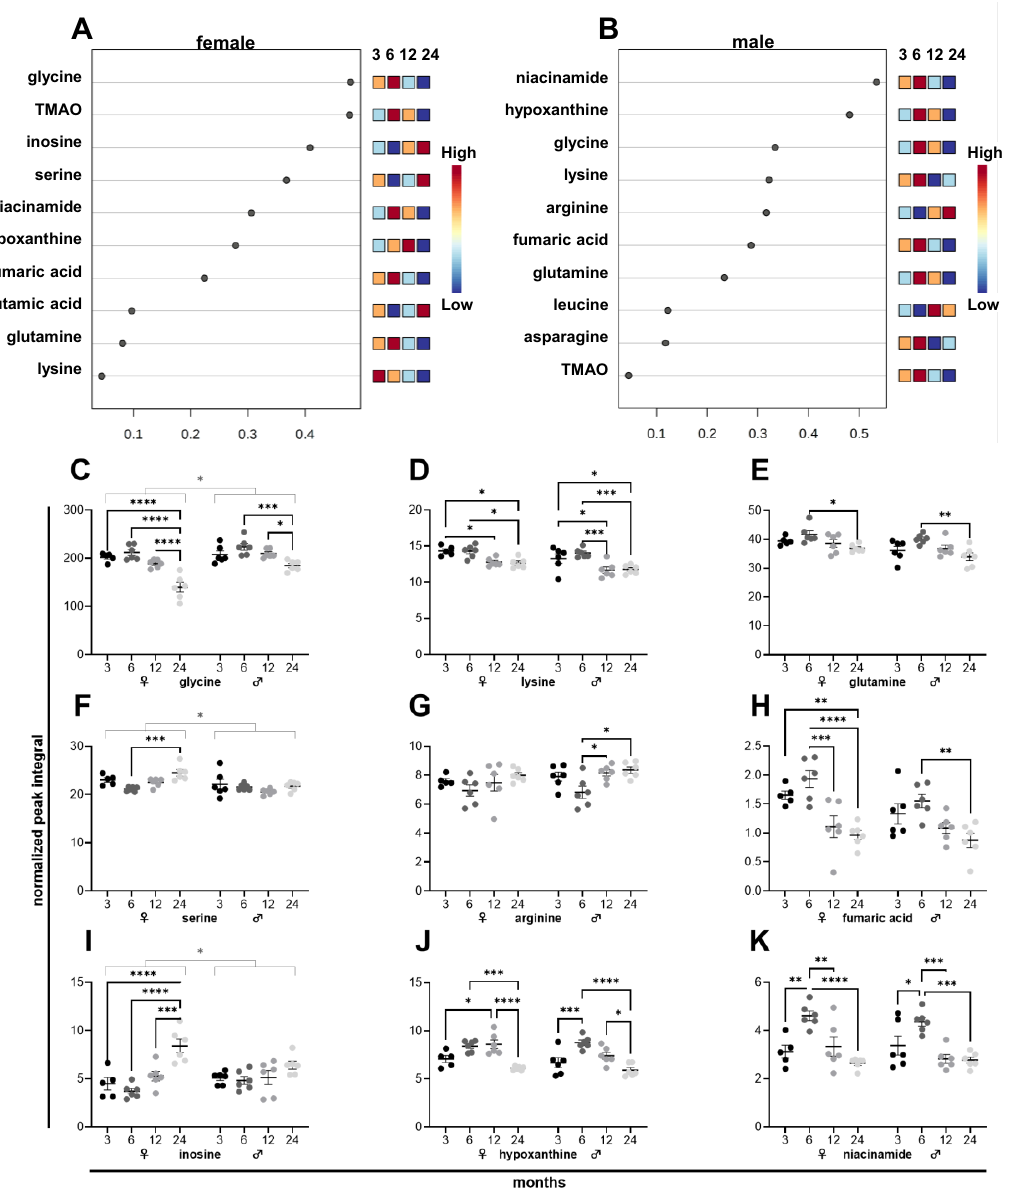
Figure 4. NMR metabolomics of female and male murine lung samples. Metabolites of five female ( A ) and six male ( B ) mice ranked based on the variable importance during projection (VIP) score as a function of age. Individual metabolite levels of female (left) and male (right) tissues at 3, 6, 12, and 24 months presented as normalized peak integral ( C – K ). TMAO Trimethylamine